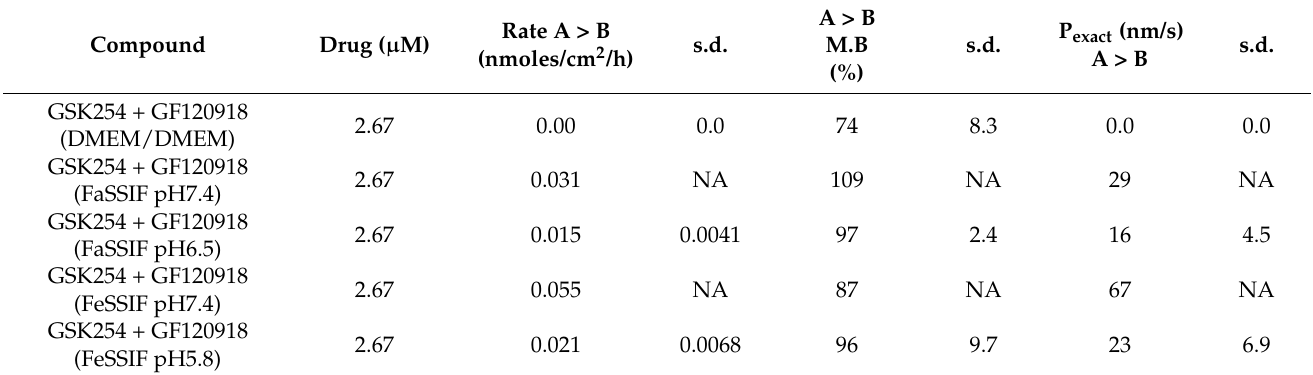
Table 4. Apparent exact permeability of GSK254 in biorelevant media using MDCK cell